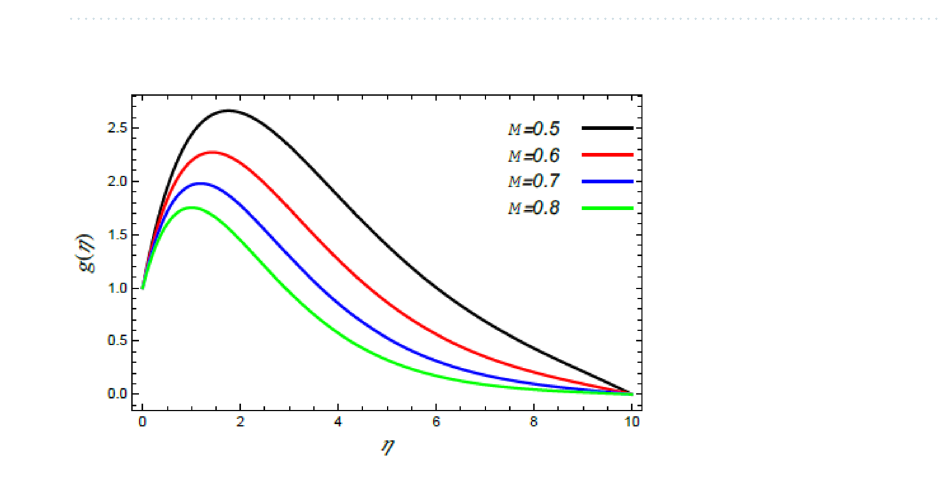
Figure 4. Deviation of the radial velocity f ′ (η) versus η as given in Eq. (64) to illustrate the impact of the magnetic factor M .